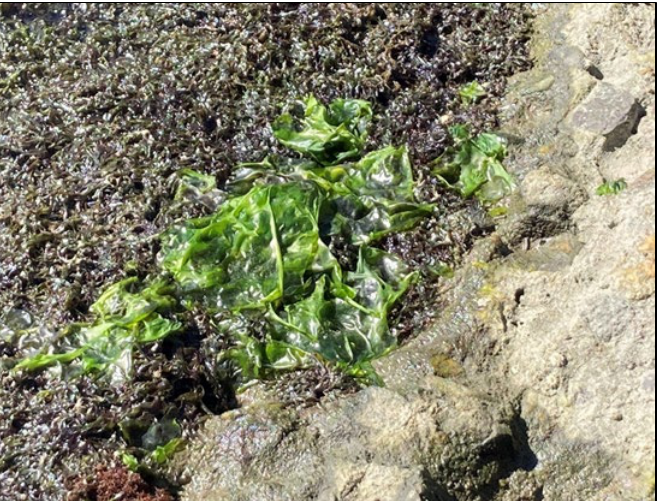
Figure 3. Image of U. lactuca at Zedler Marsh, documented on the wetland side of Station 3 by L. Massey and E. Zahn.